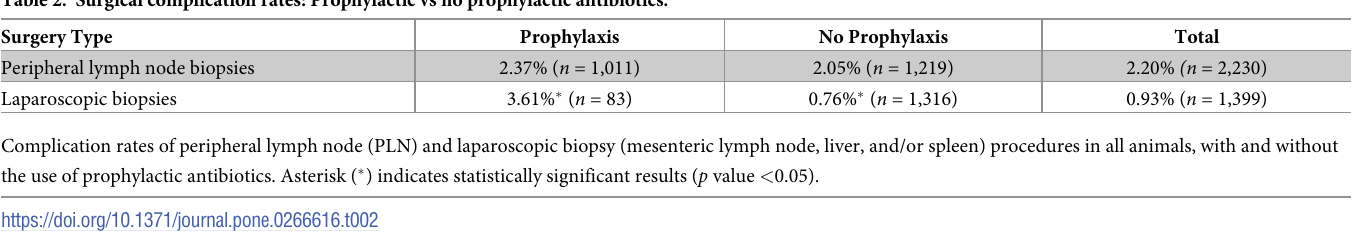
Table 3. Discussion